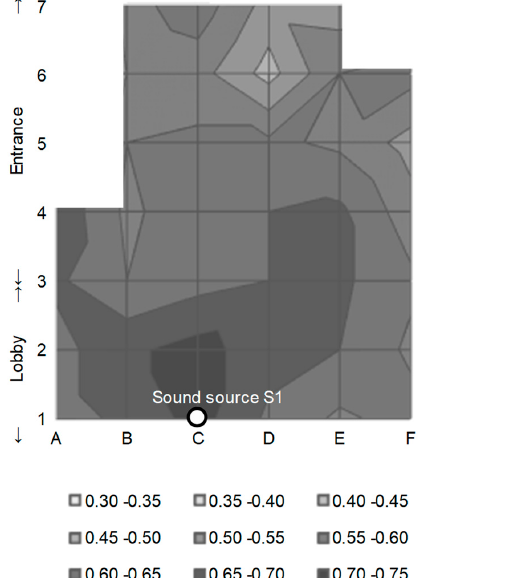
Figure 9. Relationship between the distance from the sound source and the value of RASTI: ( a ) sound source S1 and ( b ) sound source S2.